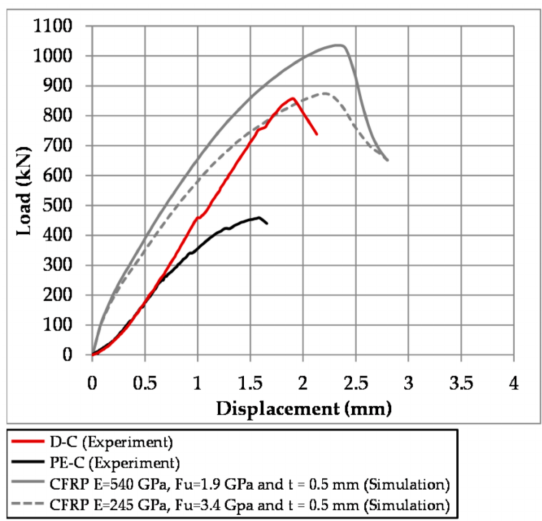
Figure 13. Load-displacement relationships for parametric study of CFRP stiffness.